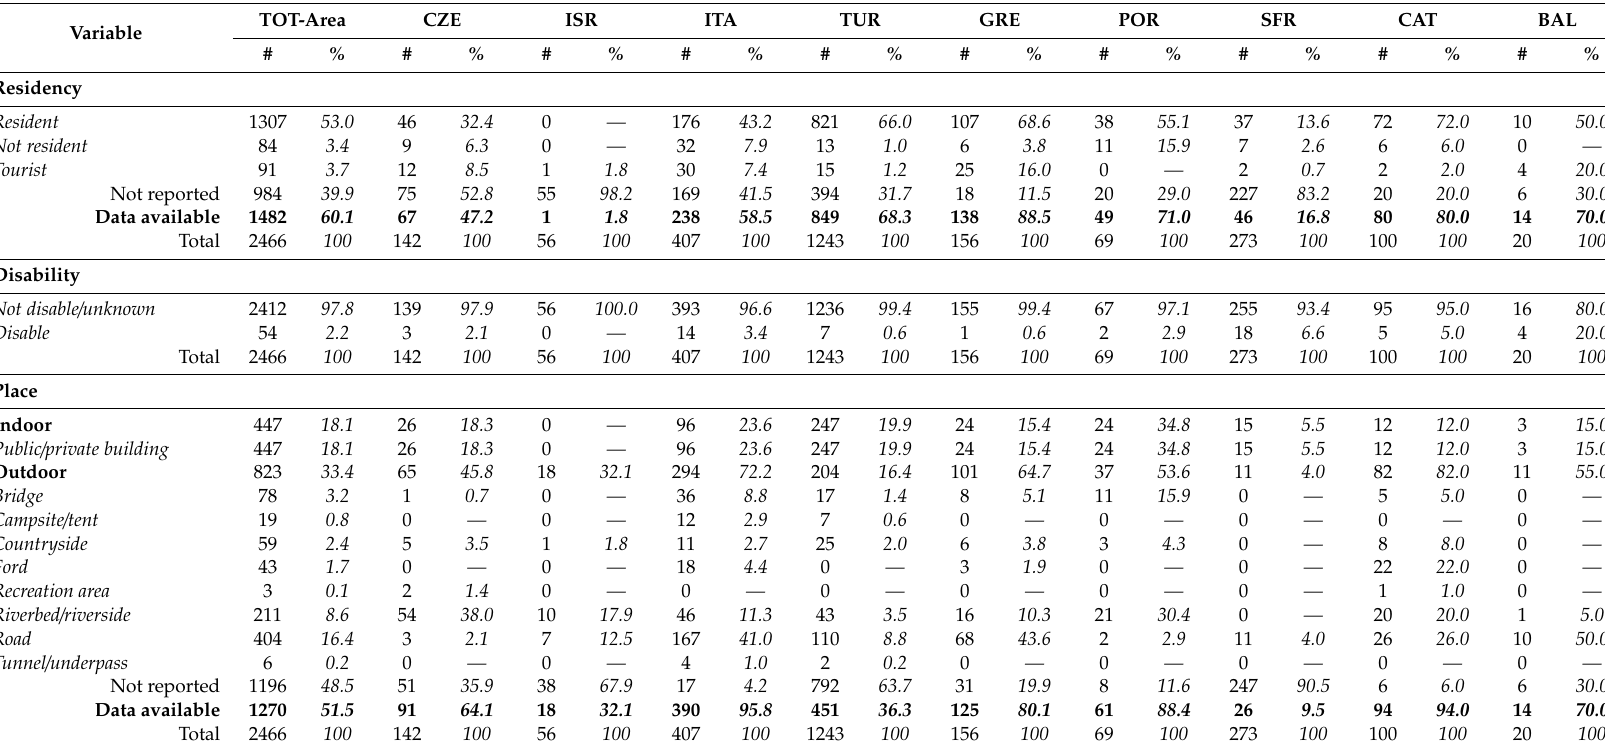
Table A2. EU FF Database: Residency and Disability of Fatalities and Place of fatal events per TOT-A, and per each SA (#: Number; %: Percentage). Data available are in bold and percentage in